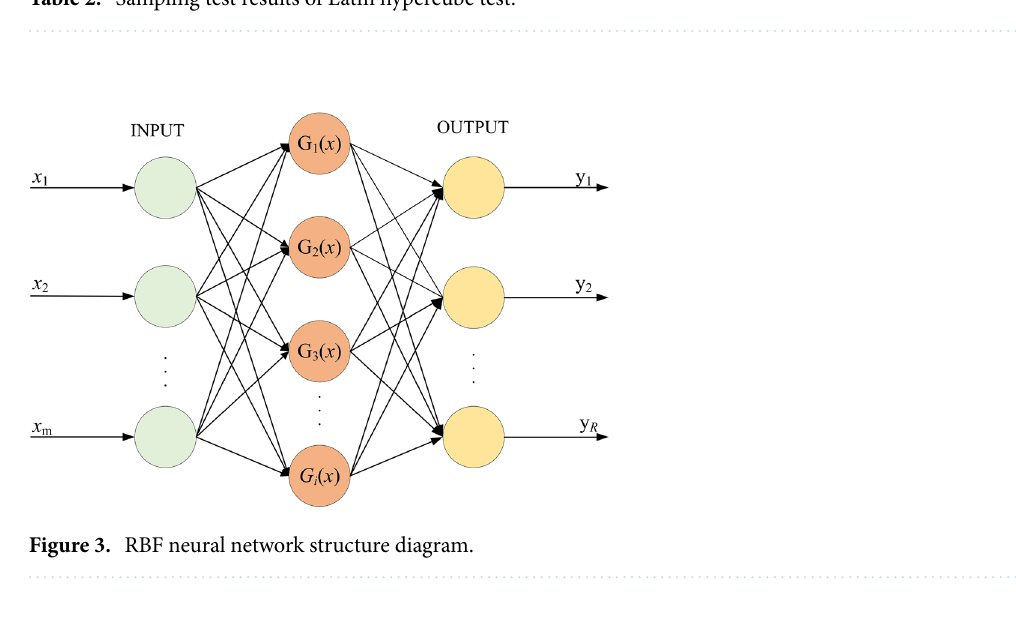
Table 2. Sampling test results of Latin hypercube test.